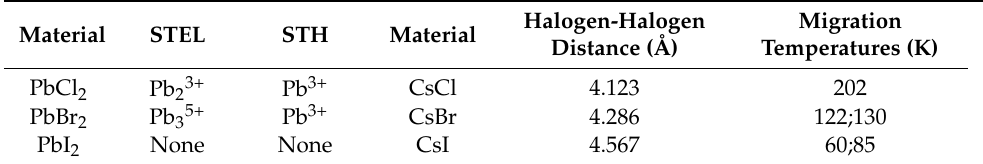
Table 1. A summary of the calculated STEL and STH for PbX 2 (X=Cl, Br, I) and the initial migration temperatures for the STH in CsX (X=Cl, Br, I).